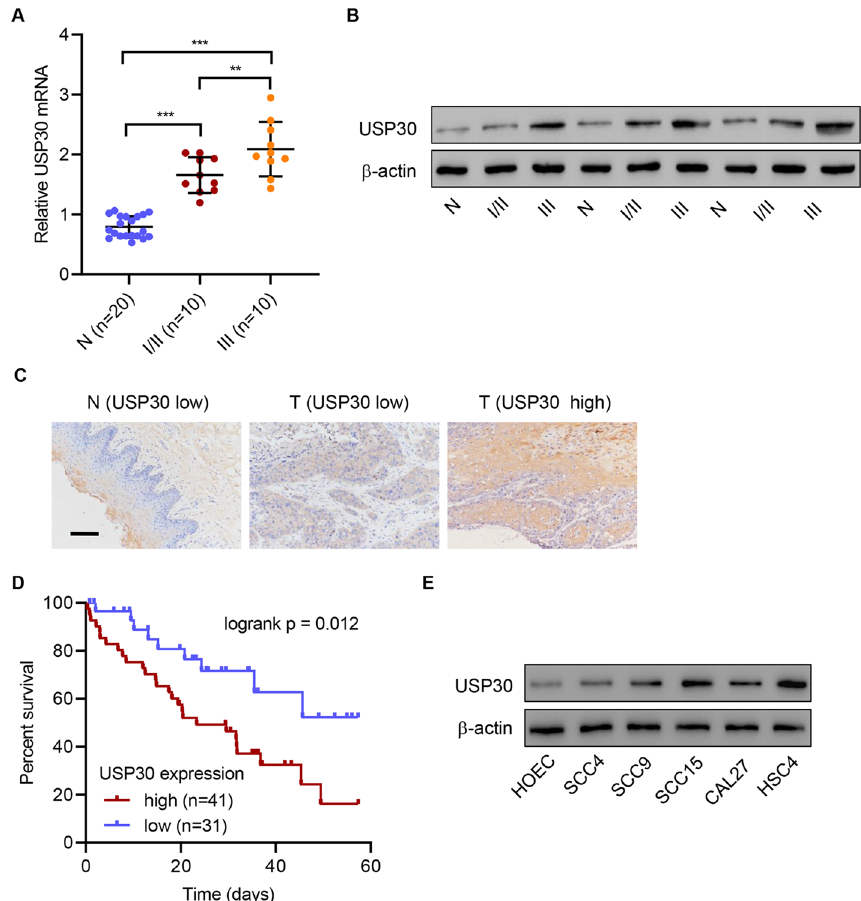
Fig. 1 USP30 upregulation is associated with poor prognosis. A mRNA and B protein levels of USP30 in stage 1 or 2 OSCC tissues (I/II), stage 3 OSCC tissues (III), and adjacent nontumor tissues (N). C USP30 protein levels in human OSCC tissue microarrays detected by IHC (scale bars: 100 μm). D Overall survival rate analysis. E USP30 expression in human OSCC cell lines and oral epithelial cell HOEC. ** P < 0.01, *** P <